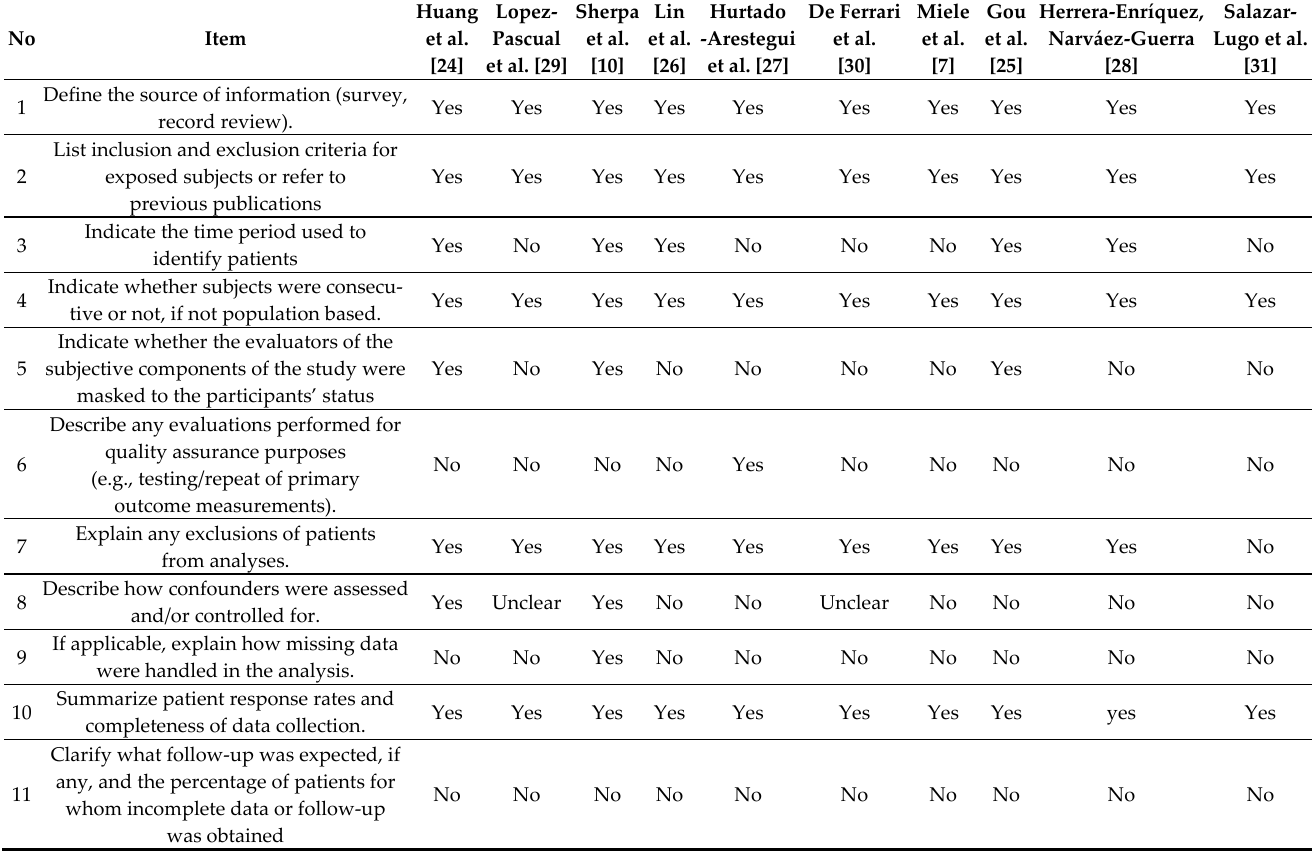
Table 1. Analysis of the methodological quality of the articles selected for this systematic review.